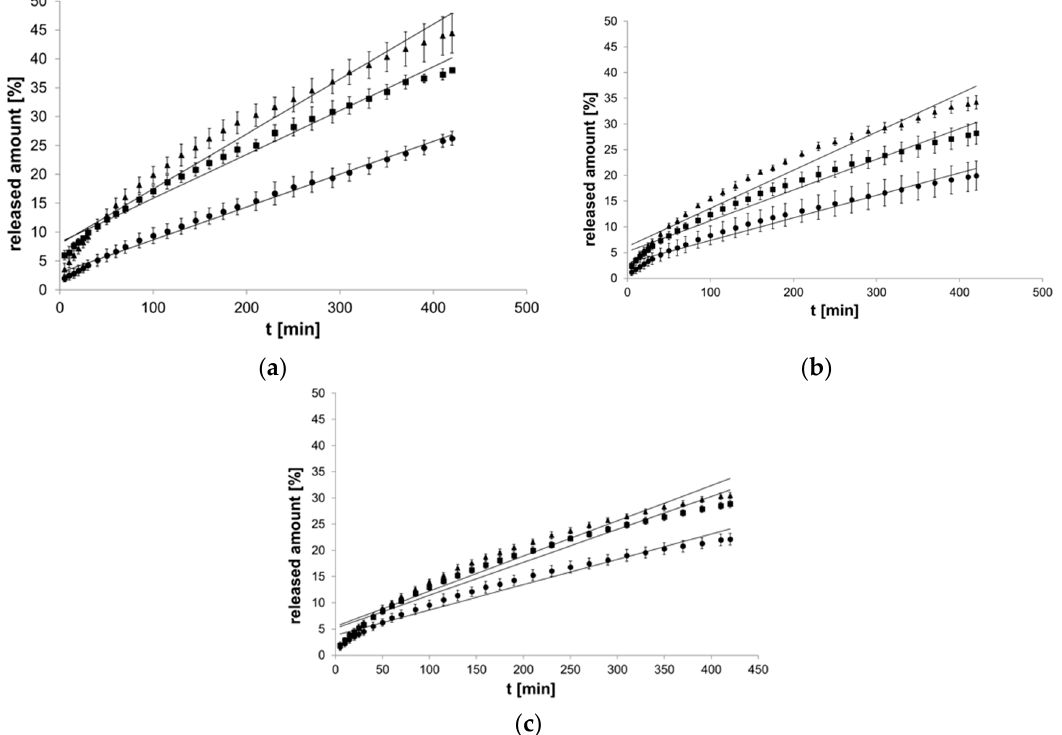
Figure 2. Process of release kinetics of β -escin ( β E) performance according to zero-order kinetics model; ( a ) MC gel formulations, ( b ) PA1 gel formulations, ( c ) gel formulations with PC-11; ▲ —reference gel, ■ —20% of MSA, ● —40% of MSA, n = 6.